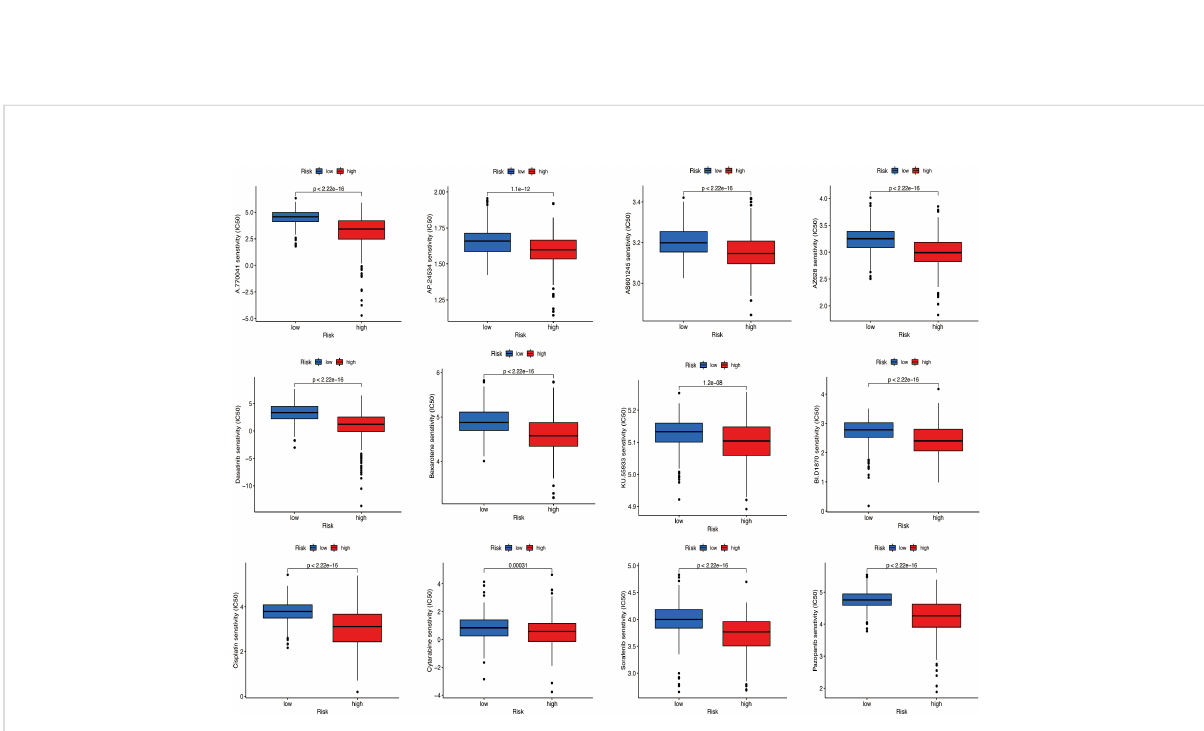
FIGURE 11 Prediction of potential chemical drugs. These drugs all had higher IC50 in low-risk